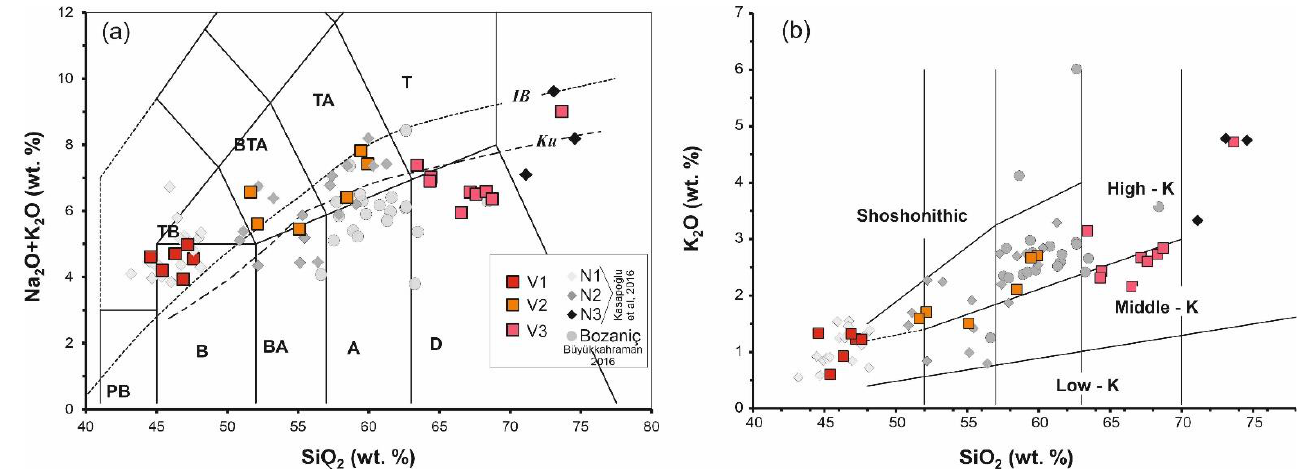
Figure 7. ( a ) Classification of the SNV (total alkali vs. silica) on diagram of [43] (TB: trachybasalt; BTA: basaltic trachyandesite; TA: trachy-andesite; T: trachyte; B: basalt; BA: basaltic andesite; A: andesite; D: dacite; IB: [44] K: [45]). ( b ) Classification of lavas on K 2 O vs. SiO 2 diagram of [46]. The lava samples from the other studies examining SNV were also plotted for comparison.